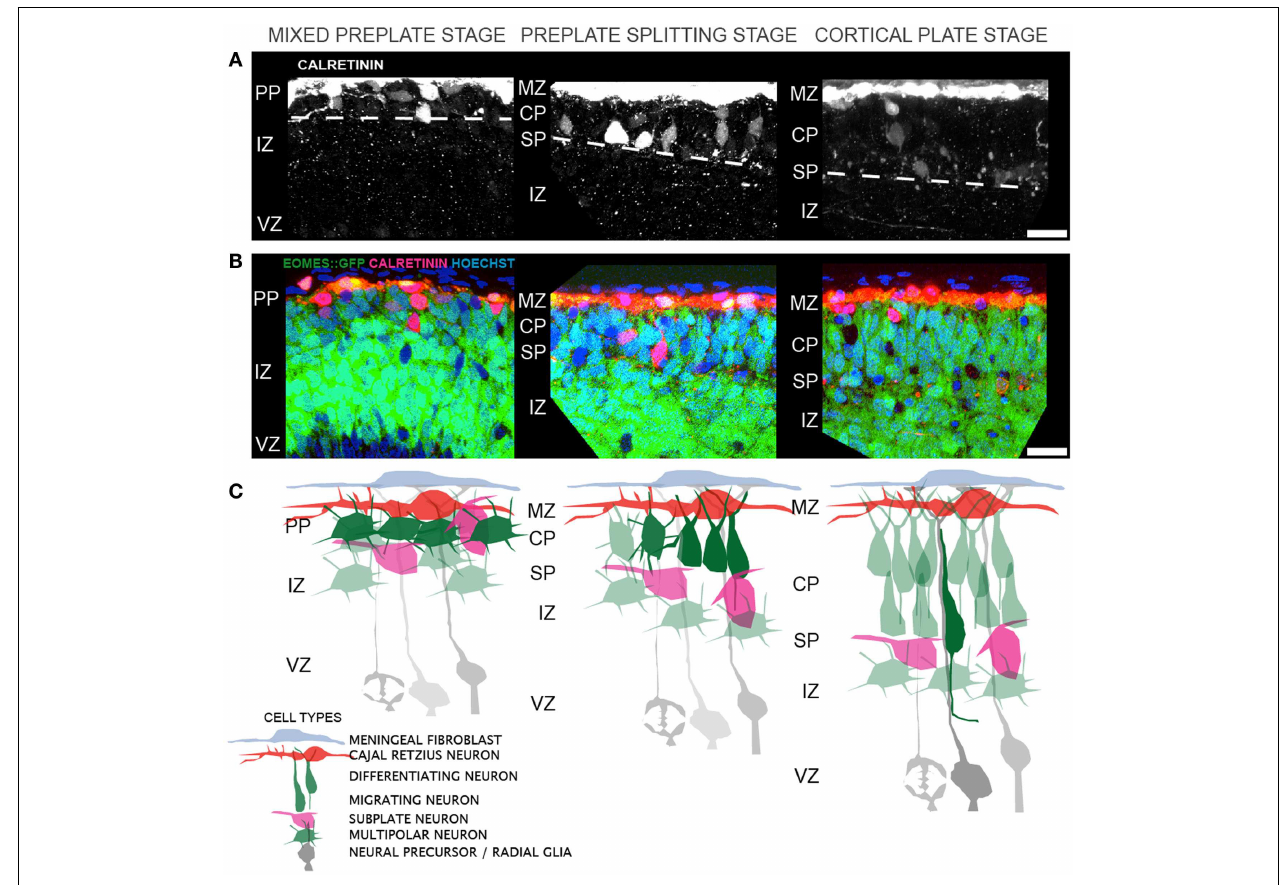
mixed preplate stage, where L6 neurons are intermingled with preplate neurons, the preplate splitting stage, where L6 neurons become radially oriented and coalesce into a recognizable cellular layer and the cortical plate stage, where migrating neurons enter the CP on radial glial fibers. Abbreviations: marginal zone (MZ), preplate (PP), cortical plate (CP), subplate (SP), intermediate zone (IZ), ventricular zone (VZ). Scale bar is 25 µ m in (A,B)